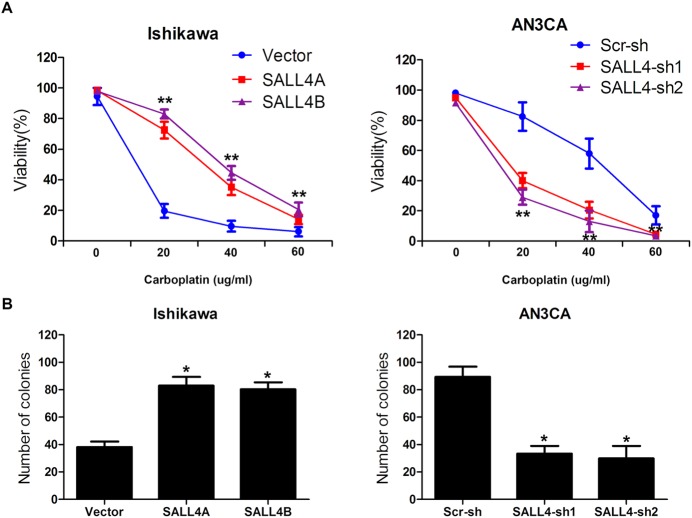
SALL4 drives endometrial cancer cells chemotherapeutic drug resistance.(A) Ishikawa cells transfected with SALL4A or SALL4B expression vector and AN3CA cells transfected with SALL4-sh1 or SALL4-sh2 were treated with the indicated concentrations of carboplatin, and cell viability assay were performed. (B) Ishikawa cells transfected with SALL4A or SALL4B expression vector and AN3CA cells transfected with SALL4-sh1 or SALL4-sh2 were treated with carboplatin, clone formation assay were performed. **P<0.01, *P<0.05.